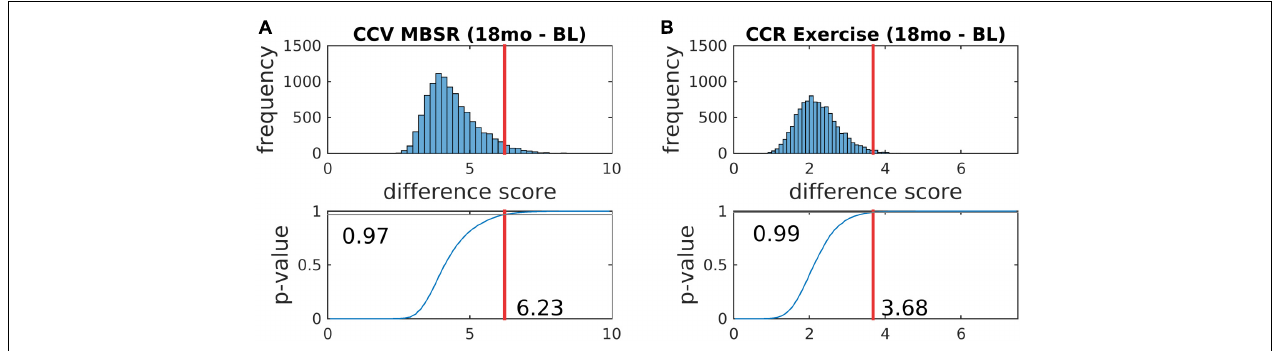
FIGURE 7 | Statistical testing of the effects of mindfulness training and exercise on FC by permutation resampling (10,100 surrogate samples). (A,B) Correspond, respectively, to Figures 5 , 6 . The red lines indicate the likelihood that the actual experimental outcome arose by chance. p -values corresponding to other contrasts are reported in Table 4 .